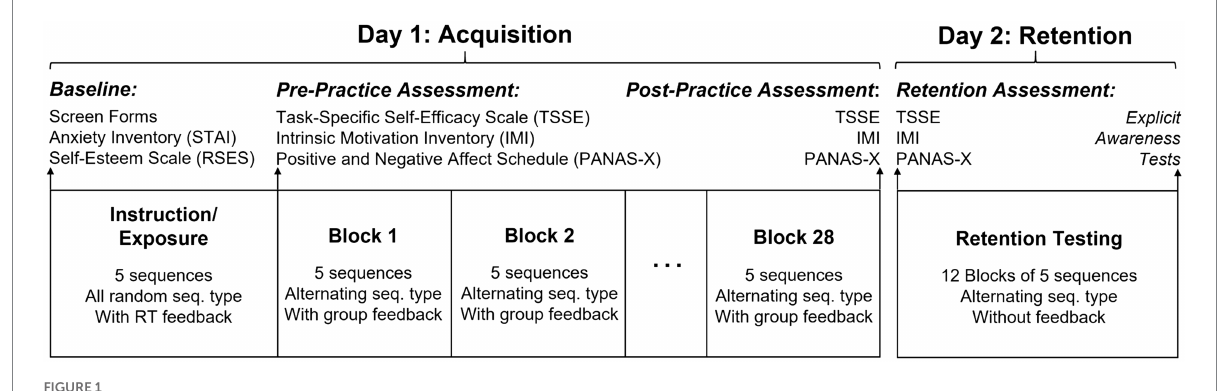
FIGURE 1 Overview of experimental design.